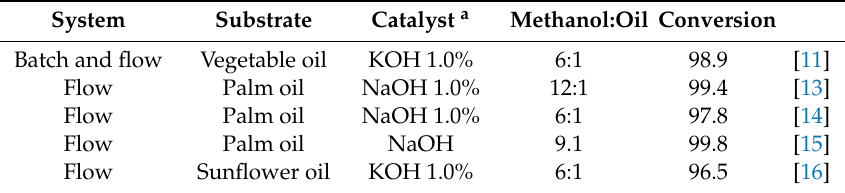
Table 1. MW-assisted processes for biodiesel preparation.